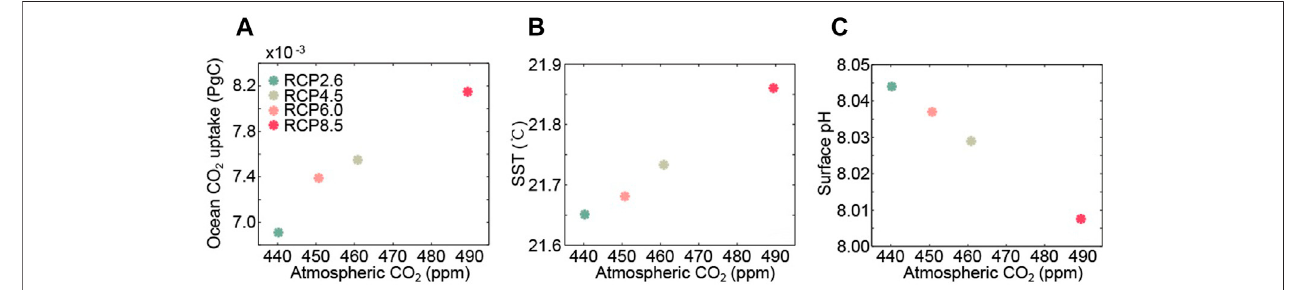
FIGURE 8 | Prescribed atmospheric CO 2 concentration against model-simulated (A) oceanic CO 2 uptake, (B) sea surface temperature, and (C) sea surface pH in Zhejiang offshore at 2040. Results are shown for the four simulations using the four RCP scenarios depicted in the Data and Modeling section, revealing the nonlinearity relationships among the atmospheric CO 2 scenario used, oceanic climate, and carbon cycle fi elds.